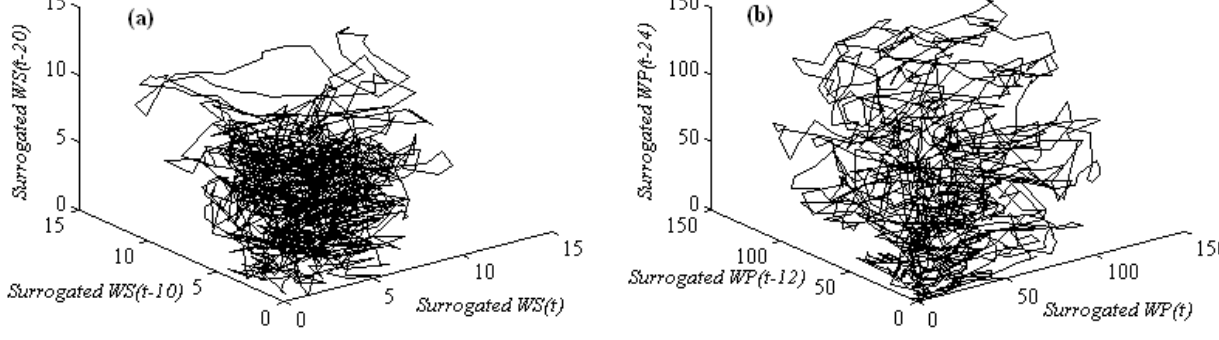
Figure 8. (a) The phase space plot of the surrogated the wind speed ( 10 τ  ); and (b) that of the wind power ( 12 τ 